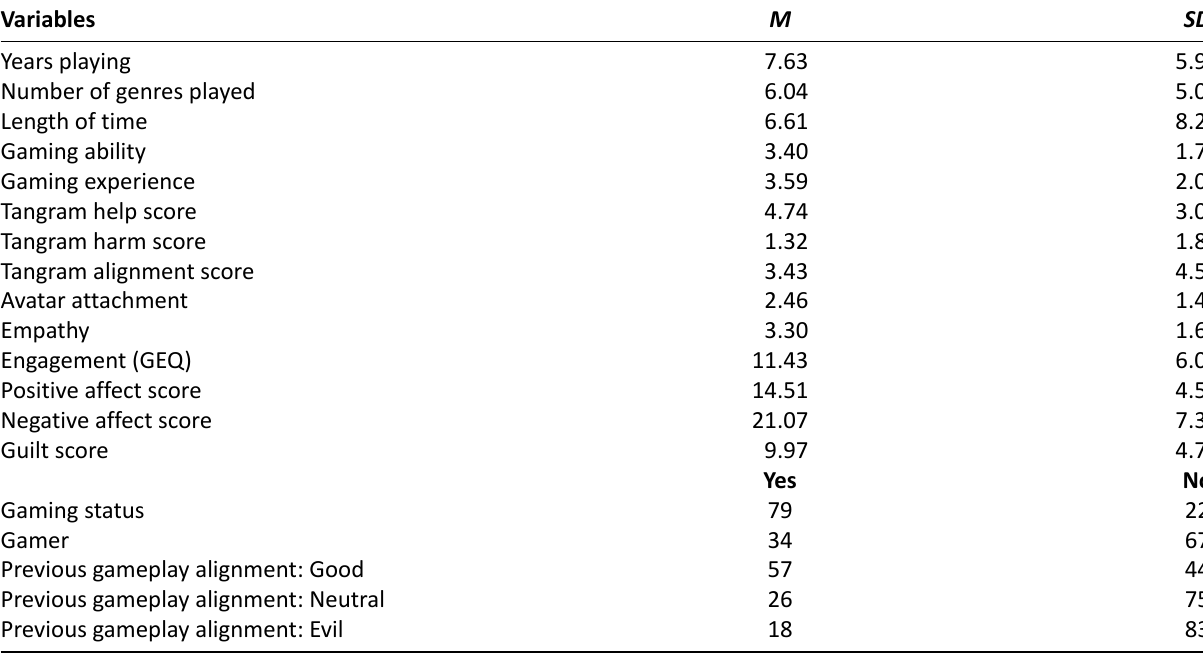
Table 2. Descriptive statistics of continuous and categorical predictor variables.